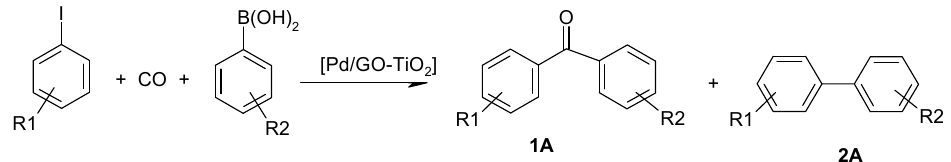
Figure 5. The carbonylative Suzuki-Miyaura reaction. Table 3. Substrate screening using Pd/GO-TiO 2 a.